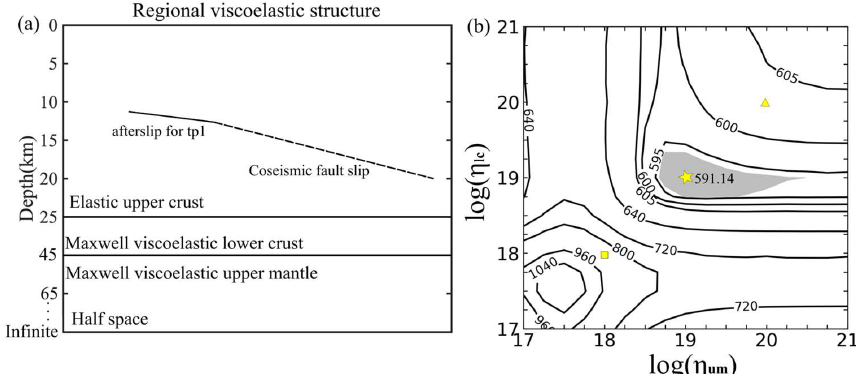
Figure 5. ( a ) Regional layered model. The upper crust depth is shown at 4:1 scale for visual clarity; the lower crust and upper mantle depth are shown at 1:1 scale; ( b ) misfit contour map in η lc and η um space. The yellow star is model 1 (best-fitting model) in Figure 6; the yellow square is model 2 in Figure 6; the yellow triangle is model 3 in Figure 6. The black dash line in ( a ) is the coseismic fault. The black solid line in ( a ) is the afterslip fault. The gray-shaded area in ( b ) denotes 95% confidence interval.